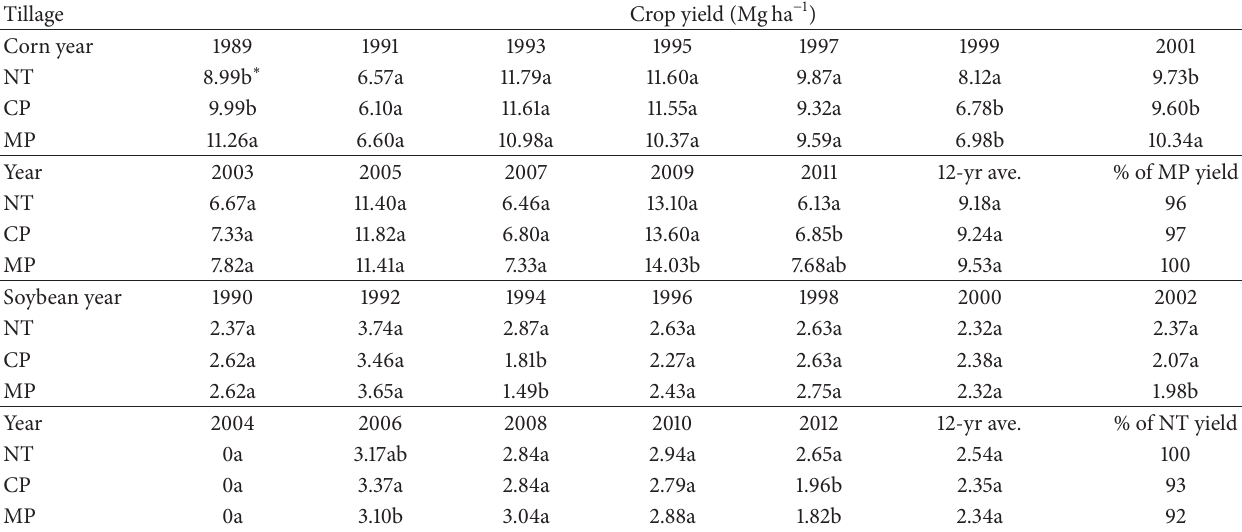
Table 4: Effect of different tillage treatments on corn and soybean yields during 1989–2012 at Dixon Springs.